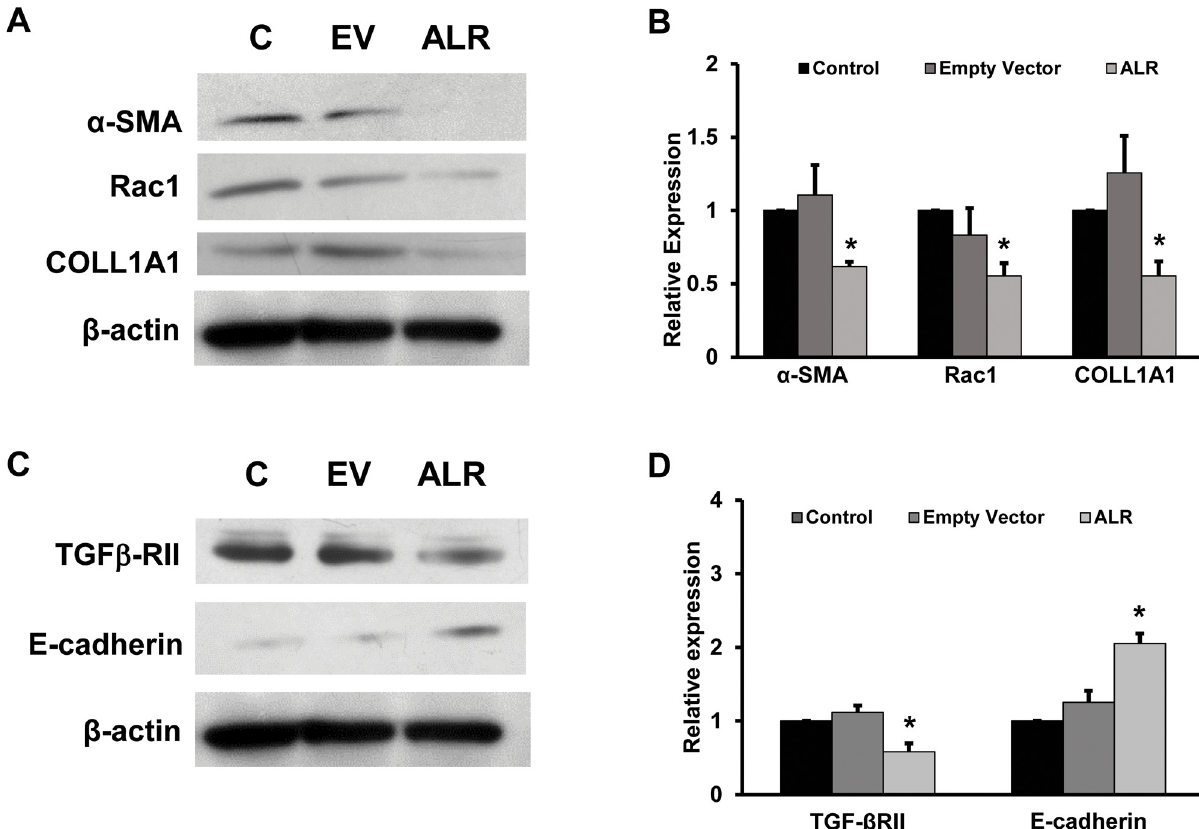
Fig 5. Effect of ALR on fibrogenic markers, TGF- β RII and E-Cadherin. The total cellular protein was isolated from ALR overexpressing cells and Western blots were performed. C, Control; EV, Empty Vector tranfected cells; and ALR, ALR expressing cells. A. The representative picture shows the Western blot results of α -SMA, rac1, COLL1A1 and β -actin (n = 3). B. The Western blots from 3 experiments of the firbogenic markers were quantitated using Image J software and presented as relative expression ( � p < 0.05, compared to control). C. Western blots were performed to determined the expression of TGF- β RII and E-cadherin. D. The band intensities of TGF- β RII and E-cadherin was quantitated by Image J software and presented as relative expression (n = 3; � p < 0.05, compared to control).